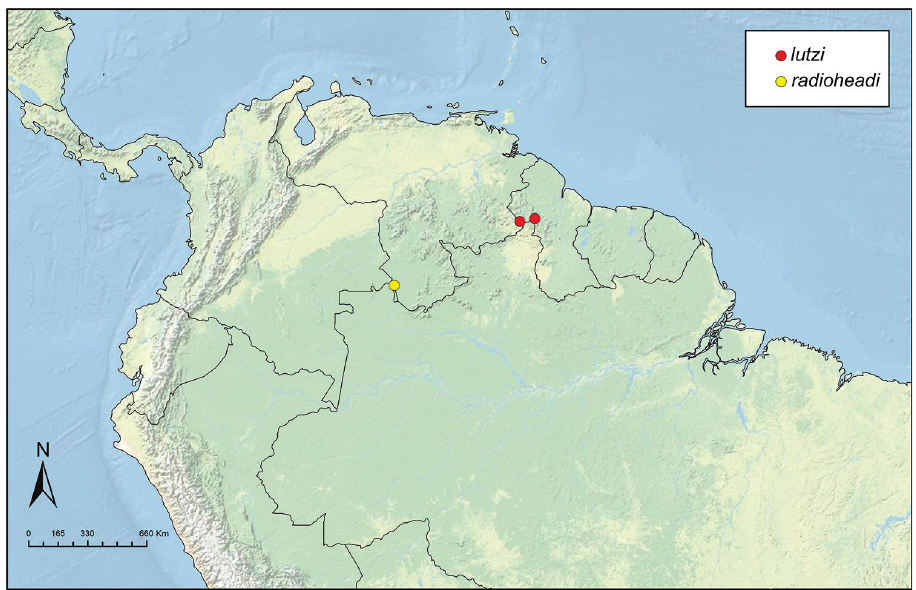
Figure 31. Distribution map of S. lutzi and S. radioheadi